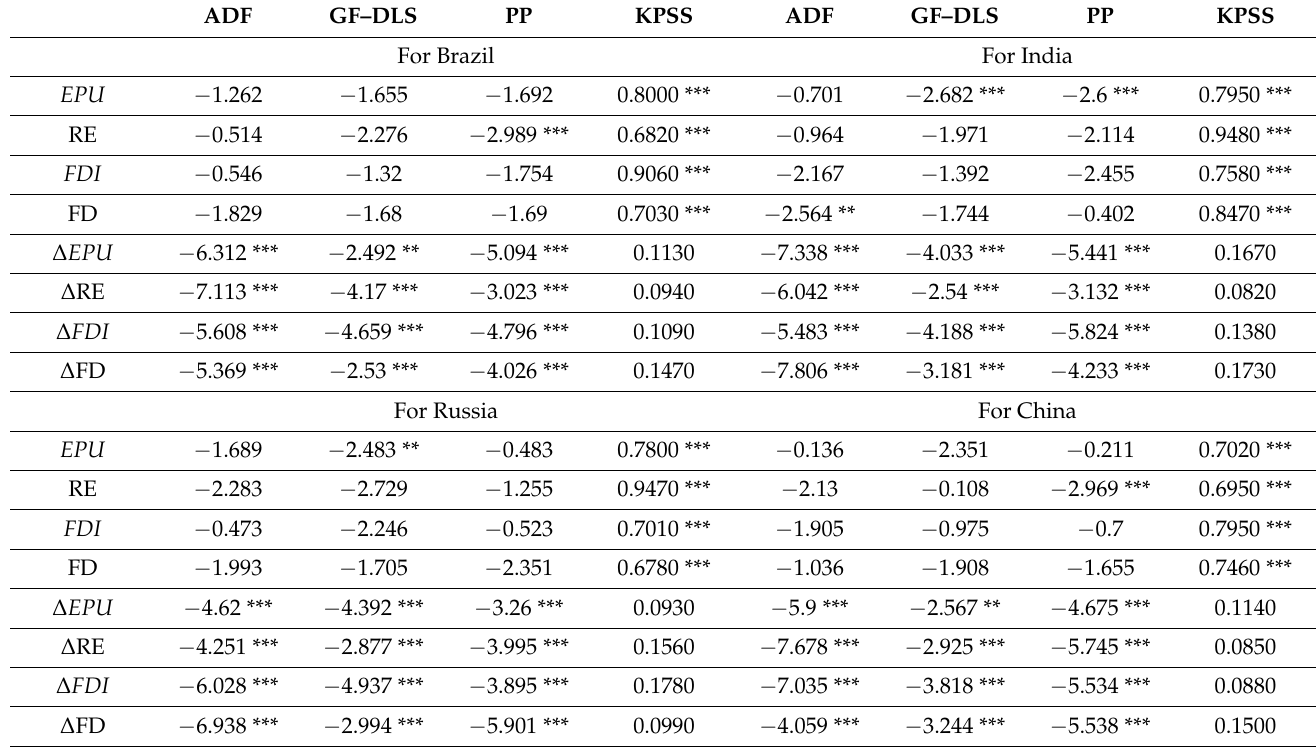
Table 3. Results of first–generation unit root